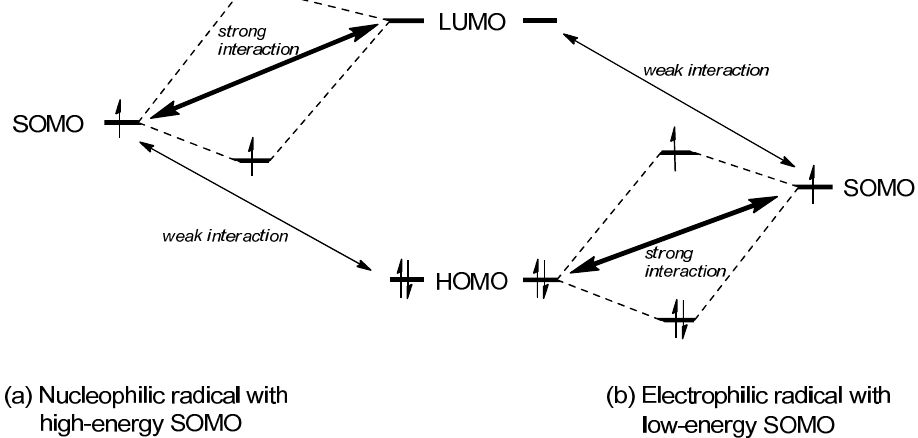
Figure 1. Interactions of discrete SOMO energy levels with the HOMO/LUMO of a molecule and frontier orbital interaction for a nucleophilic and an electrophilic